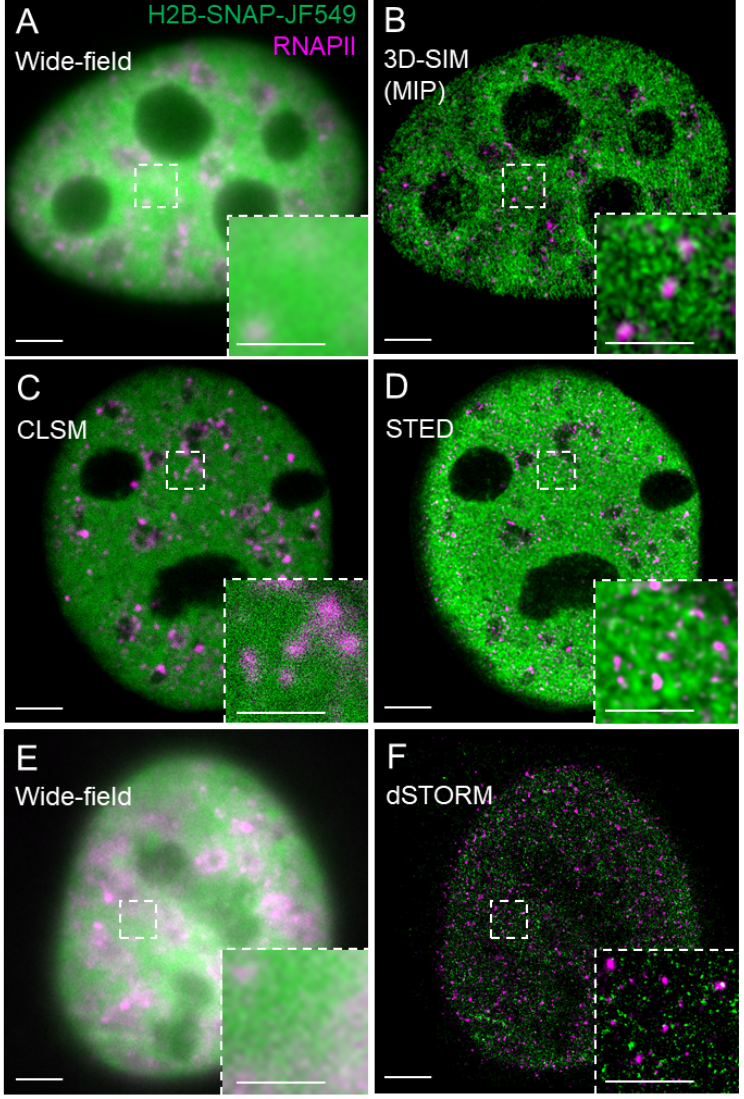
Figure 1. Visual comparison of SIM, STED, and dSTORM. Nuclei of U-2 OS cells expressing histone H2B tagged with SNAP-tag were labeled with the JF549 SNAP substrate (H2B-SNAP-JF549, green), chemically fixed, and indirectly immunolabeled against RNAPII with a secondary antibody conjugated with Alexa Fluor 647 (magenta, Abberior STAR 635P for STED). The same cell was imaged by ( A ) wide-field and ( B ) 3D-SIM (MIP—maximum intensity projection of a 3D-SIM z-stack); ( C ) confocal laser scanning microscopy (CLSM) and ( D ) STED microscopy followed by deconvolution; ( E ) wide-field and ( F ) 2D dSTORM. Construct H2B-Halo-SNAP and Janelia Fluor (JF)549 SNAP tag substrate were kind gifts of Xavier Darzacq from UC Berkeley and Luke Lavis from Janelia Research Campus of the Howard Hughes Medical Institute, respectively. Bar = 5 µm; inset 1 µm.